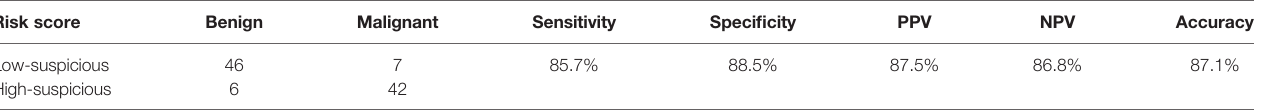
TABLE 8 | Validation of the risk score.